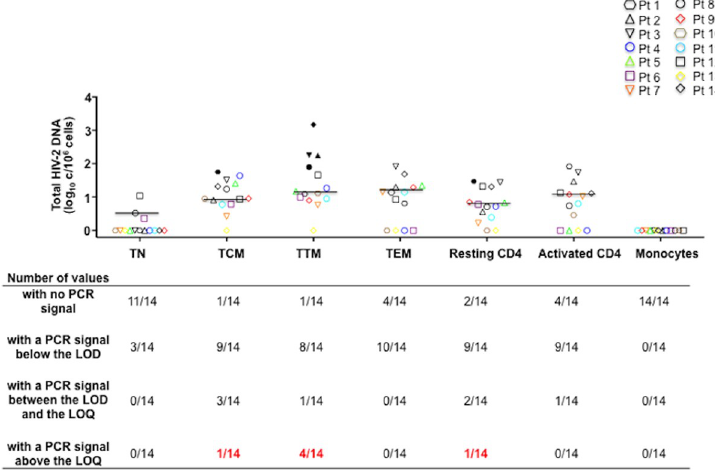
Fig 2. The distribution of total HIV-2 DNA was quantified in various sorted populations from peripheral blood mononuclear cells (PBMCs) from 14 HIV-2 infected subjects. Total HIV-2 DNA quantification in CD3-CD4-CD14 + Monocytes, CD25+CD69+HLADR+ activated CD4 T-cells and CD25-CD69-HLADR- resting CD4 T-cells sub- sorted into: naive (TN; CD45RA+CCR7+CD27+) central-memory (TCM; CD45RA-CCR7+CD27+) transitional memory (TTM; CD45RA-CCR7-CD27+) and effector-memory cells (TEM; CD45RA-CCR7-CD27-). Results are expressed as the log 10 HIV-2 DNA copies per million cells, and medians are shown. Each symbol represents a subject. Filled symbols show quantifiable DNA detection. The limit of detection (LOD) of the HIV-2 DNA assay is 3 copies/ PCR and the limit of quantification (LOQ) is 6 copies/PCR.